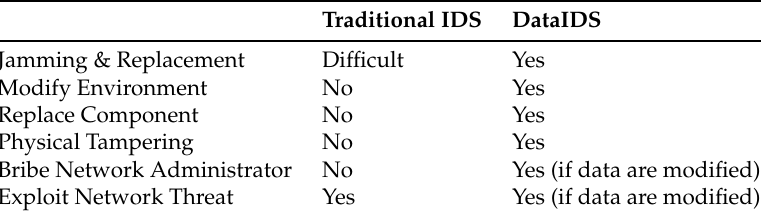
Table 1. Attack detection comparison.